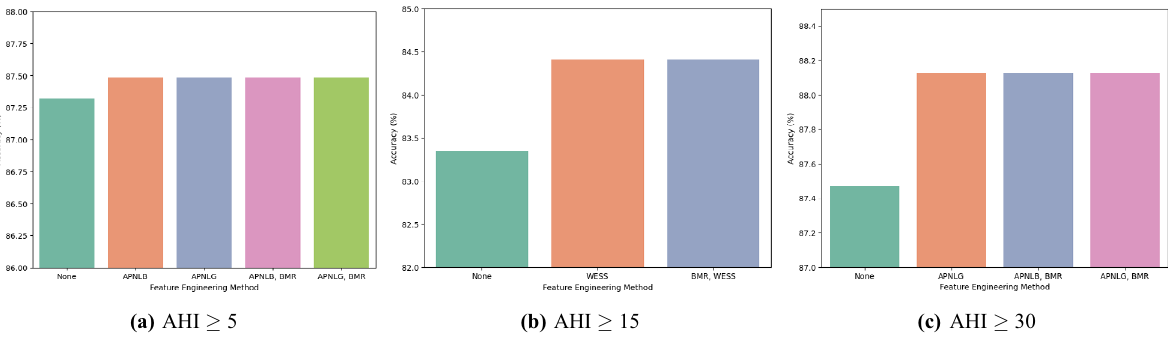
Figure 5. Comparisons of classification accuracy by feature engineering methods. The accuracy of the best performing feature engineering methods and the accuracy of those without the applied feature engineering methods were compared. APNLB: AHI prediction computed using NC in a lying position with EDS criteria from the work of Bouloukaki et al., APNLG: AHI prediction computed using NC in a lying position with general EDS criteria, BMR: Body measurement ratio, WESS: Weighted ESS.